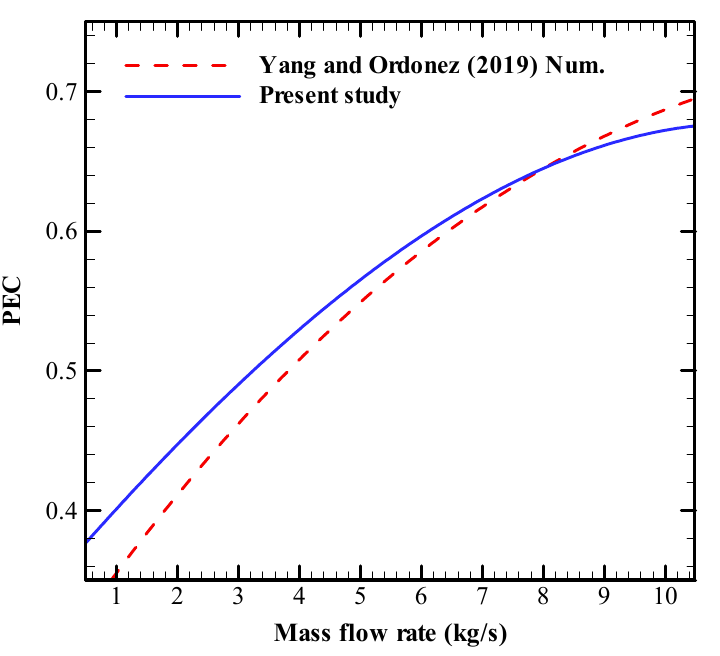
Figure 3. Code validation between numerical data of Yang and Ordonez [42] and obtained numerical